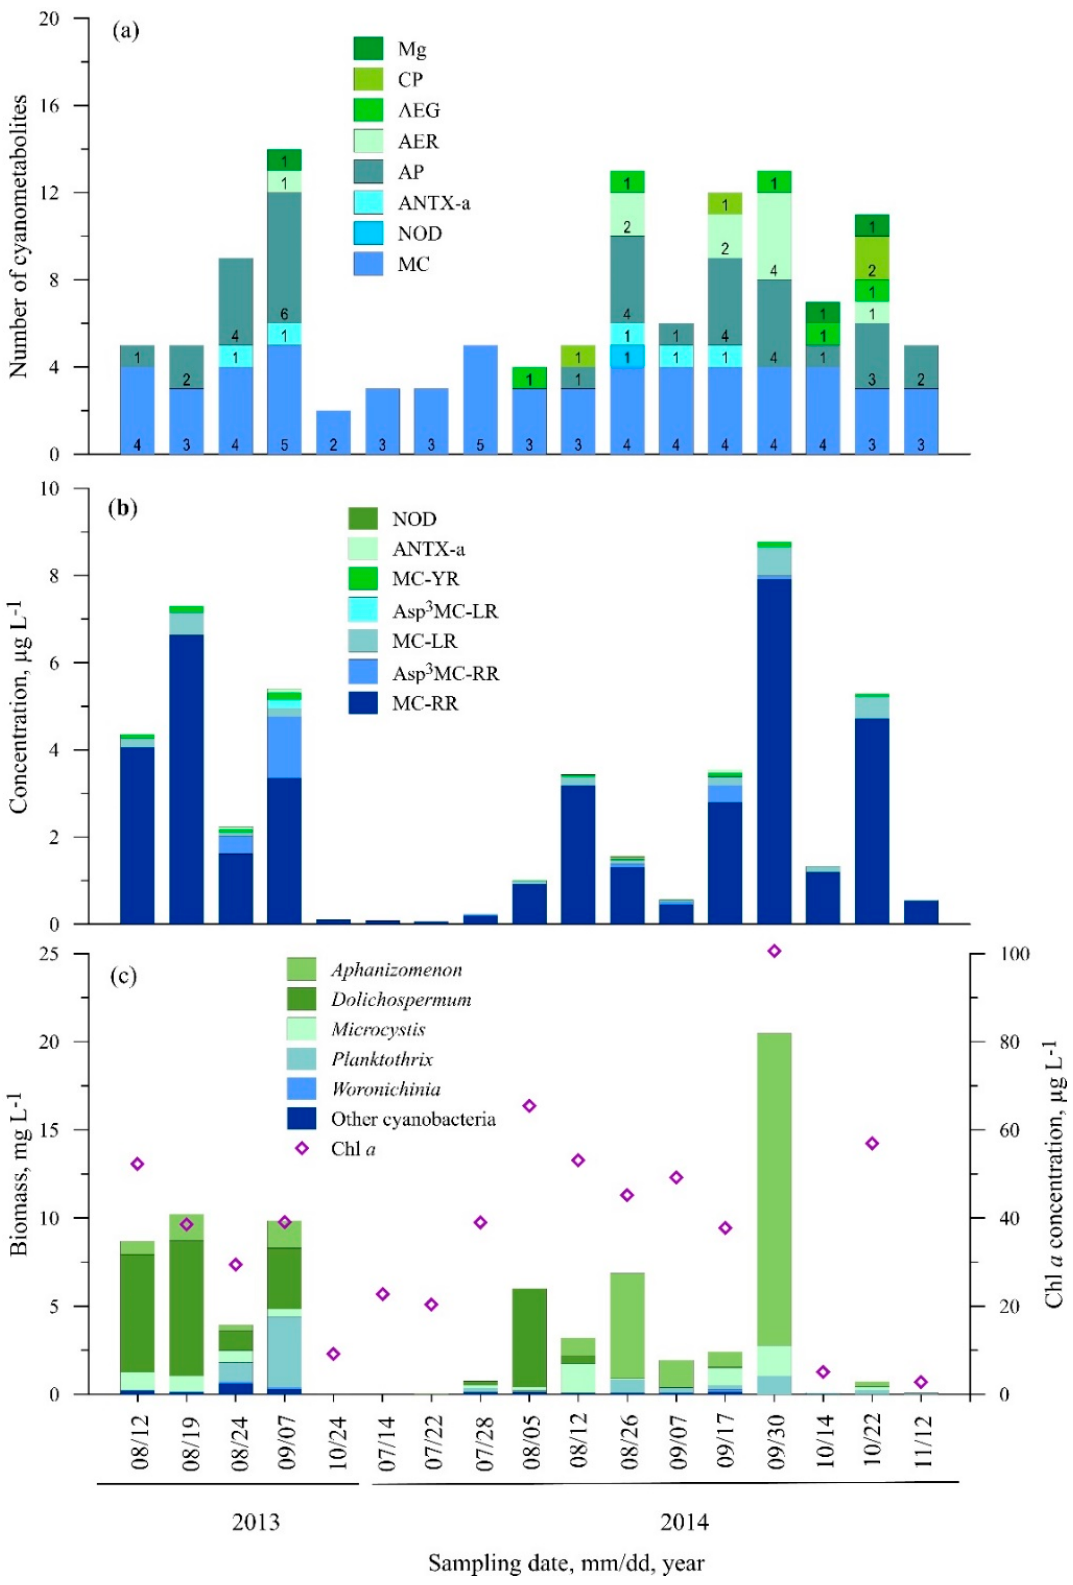
Figure 6. Seasonal changes in the number of cyanometabolites ( a ), concentration of microcystin and anatoxin variants ( b ), cyanobacteria biomass and Chl a concentration ( c ) at St. 4.